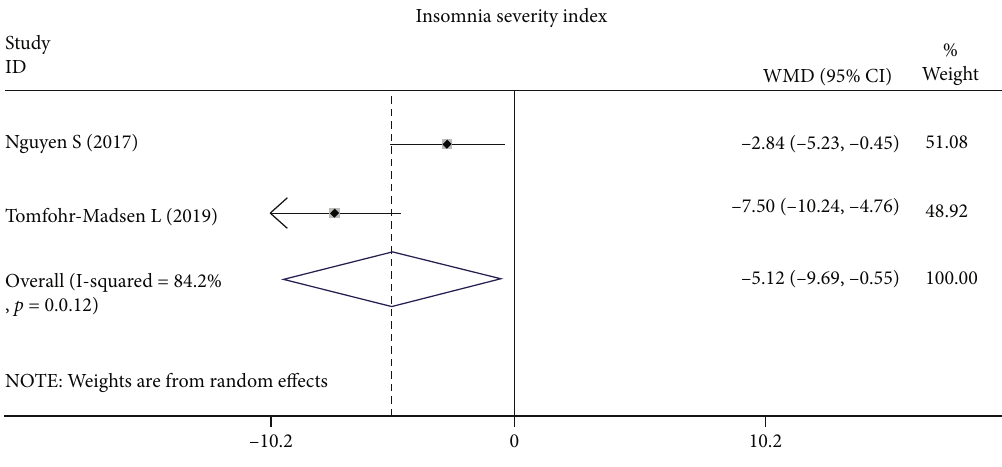
Figure 3: Di ff erences in Insomnia Severity Index scores following CBT compared with other forms of